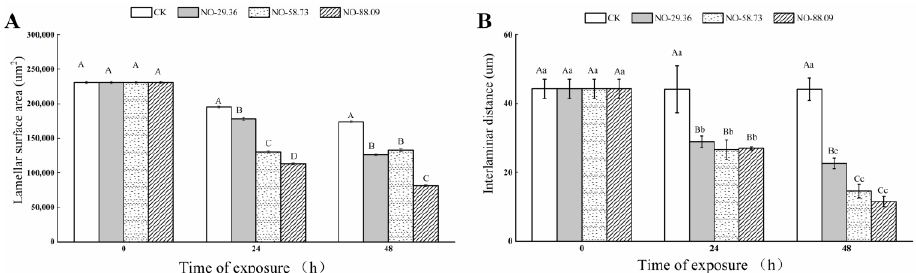
Figure 7. Quantification of fish gill structure. Lamellar surface area of gill ( A ) and interlaminar distance of gill ( B ) in large yellow croaker. Different capital letters indicate significant differences in the means between treatment groups. Different lowercase letters indicate significant differences in the means between the same treatment groups ( p <